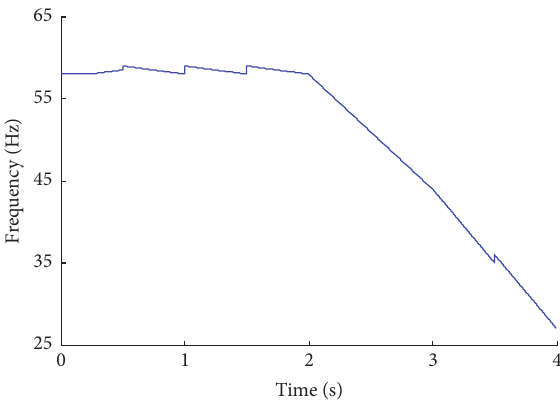
Figure 14: The IF extracted from the vibration signal in Figure 12(a) via the MSCPP